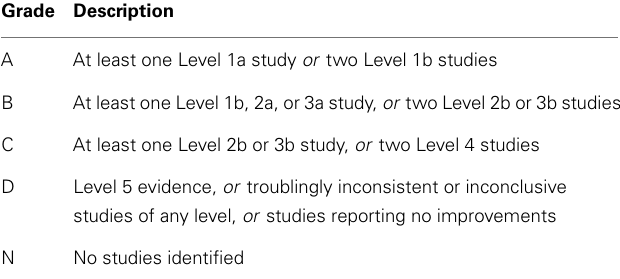
Table 2 | Grade of